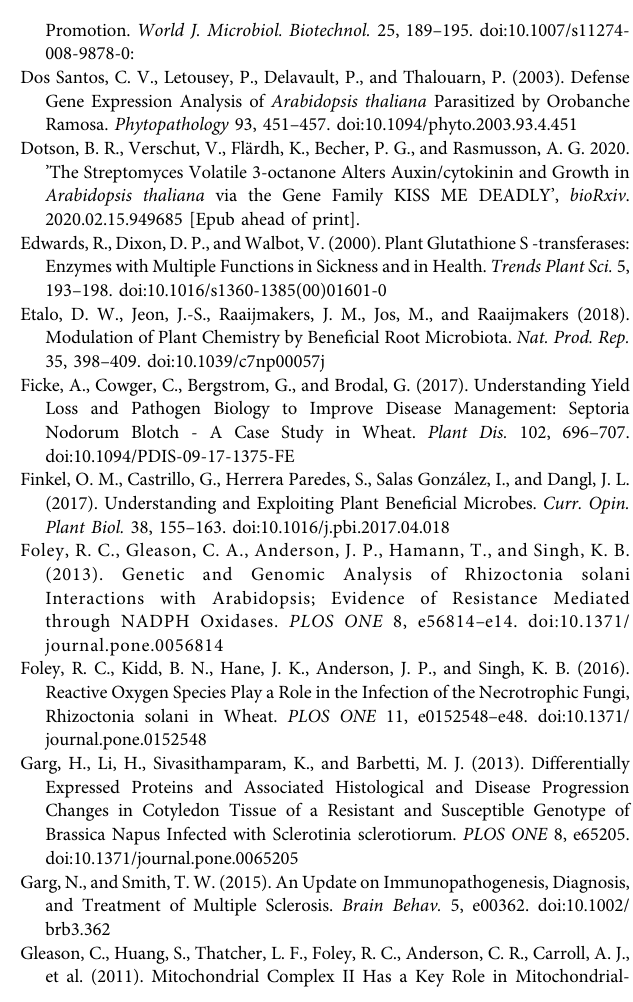
Supplementary Table S3 | qPCR program. Supplementary Table S4 | Differentially expressed genes in KB001-treated Arabidopsis plants. Shown are the up- and downregulated genes in KB001-